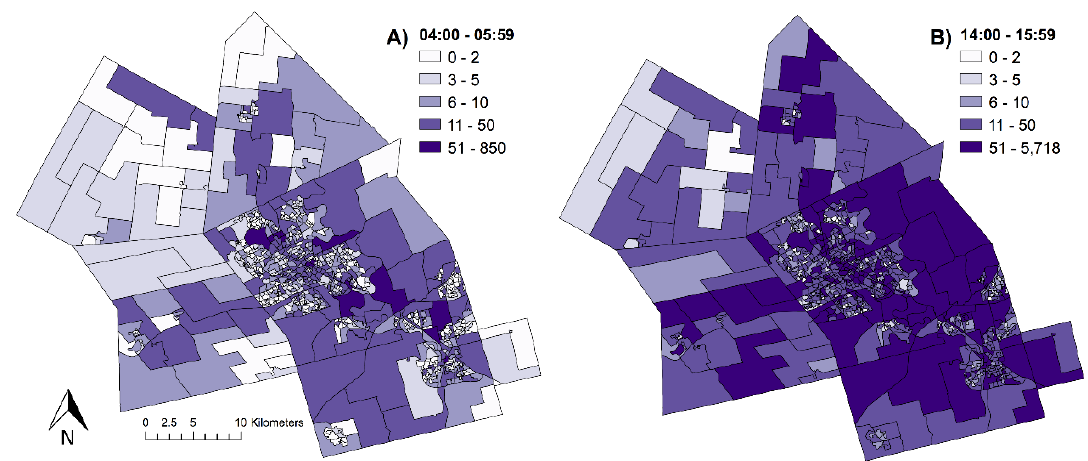
Figure 3. Geographic distribution of police calls-for-service counts for ( A ) 04:00–05:59 and ( B ) 14:00– 15:59.